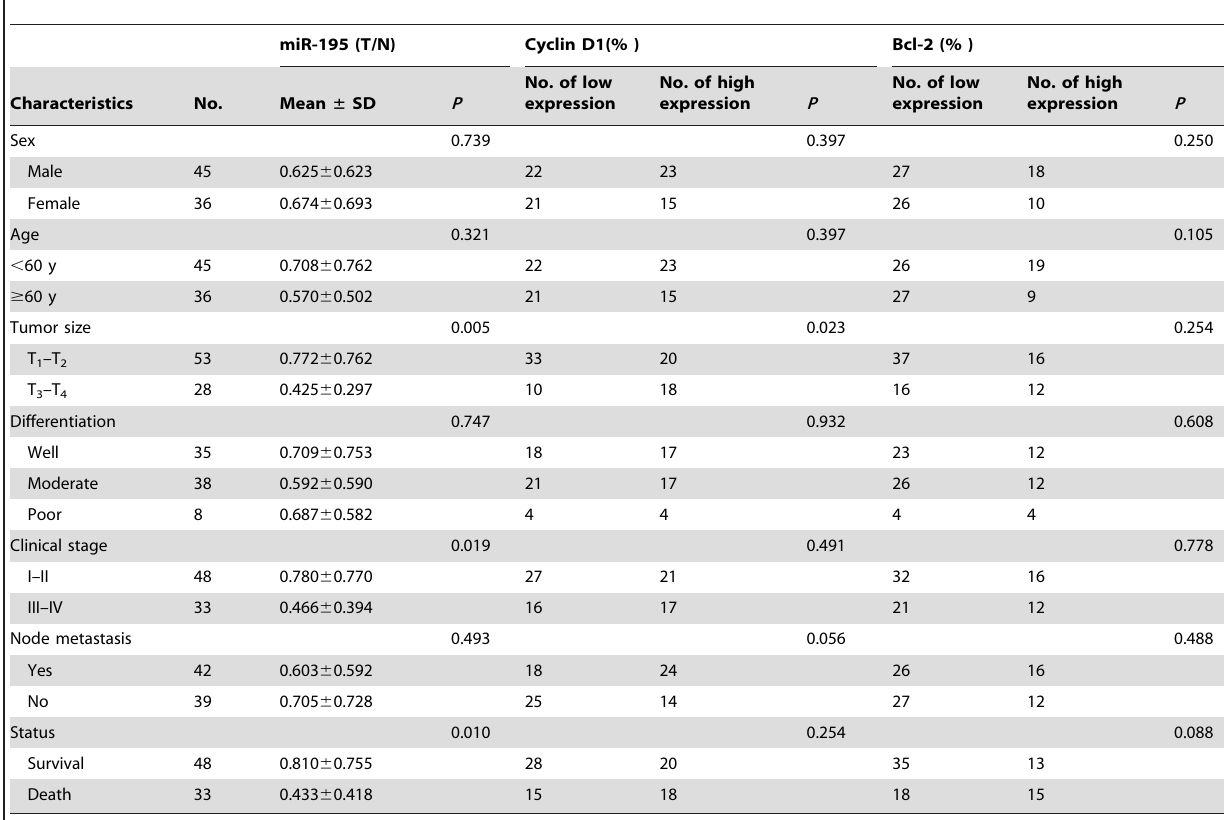
Table 1. Relationship between expression of miR-195, Cyclin D1, and Bcl-2 and clinicopathologic factors in 81 TSCC patients.